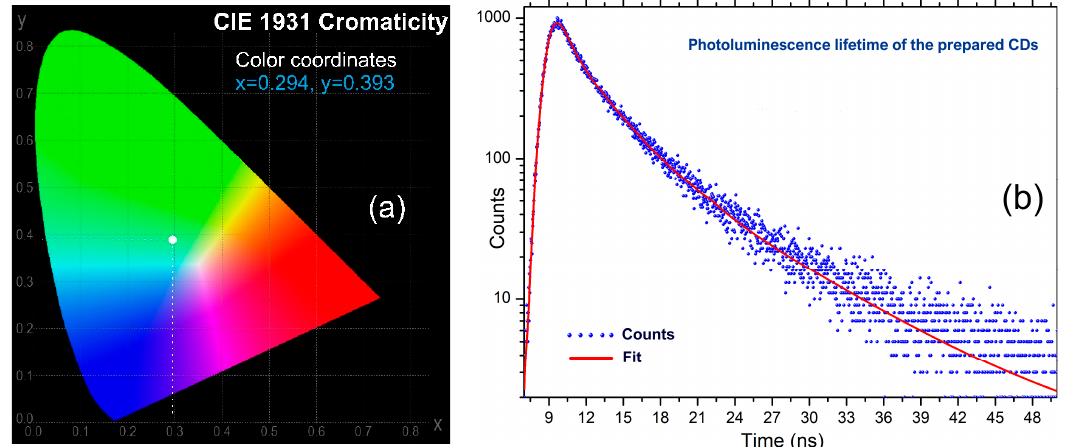
Figure 9. ( a ) CIE1931 chromaticity parameters and ( b ) PL Lifetime decay recorded for the prepared CDs.